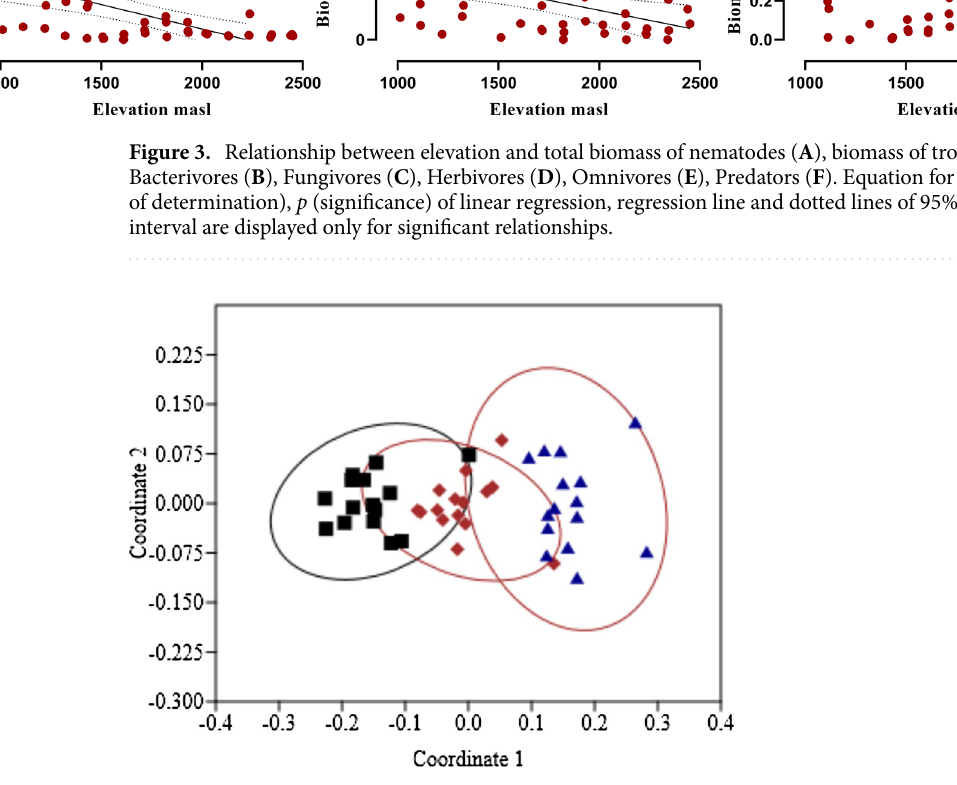
Figure 4. Non-metric multidimensional scaling (NMDS) ordination plot based on Bray–Curtis similarity measure of the nematode community between elevations. Squares represent 1000–1500 m; diamond represent 1500–2000 m and triangle represent 2000–2500 m. The circles surrounding the clusters represent 95% confidence